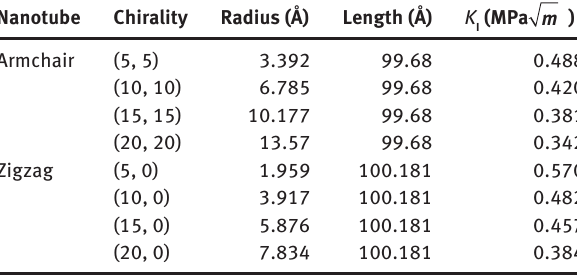
Table 3 Stress intensity factor of RVEs with armchair and zigzag